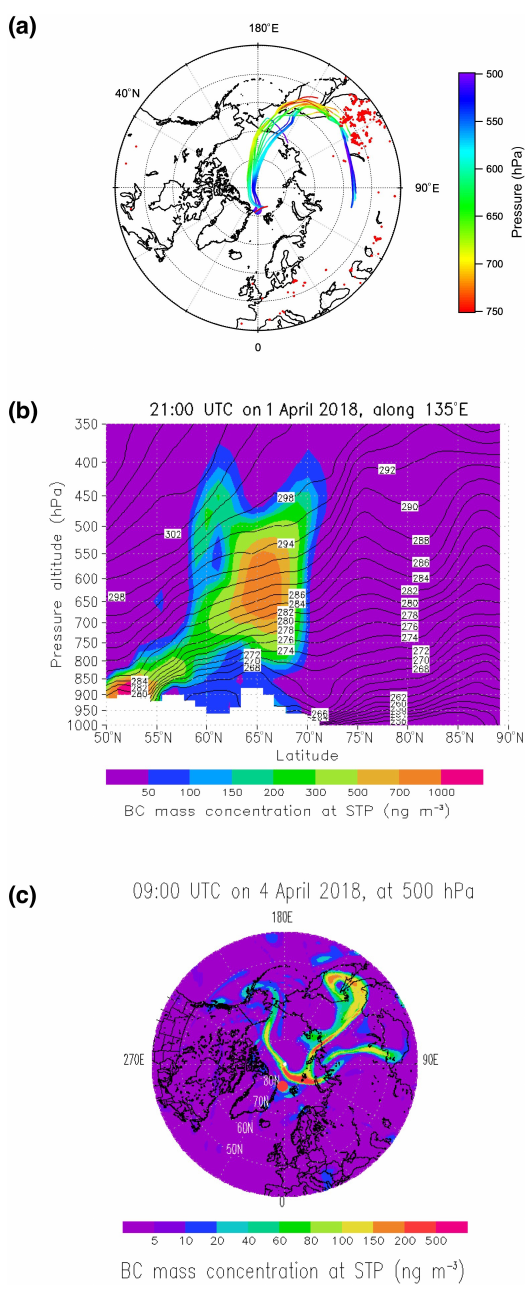
Figure 7. (a) Eight-day backward trajectories of air with enhanced BC mass concentrations ( M BC ) observed on 2, 3, and 4 April 2018 (the data points shown in red in Fig. 2a). Red points are MODIS- derived hot spots observed during 25–27 March, 8d before the aircraft observations of the enhanced M BC . (b) Model-calculated latitude–pressure-altitude cross-section of M BC along the 135 ◦ E line (color) and potential temperature (contours) at 21:00UTC on 1 April 2018 (MRI-ESM2 model). M BC values originating from BB are shown. (c) Horizontal distribution of M BC (BB origin) at 500hPa level at 09:00UTC on 4 April 2018 when the enhanced M BC data were observed (MRI-ESM2 model). The red circle de- notes the aircraft location when the enhanced M BC data were ob-